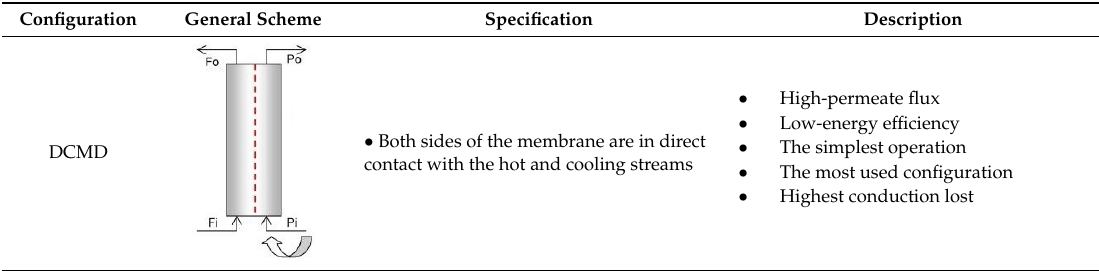
Table 1. Introduction and explanation of di ff erent configurations of membrane distillation (MD) process [14–17].